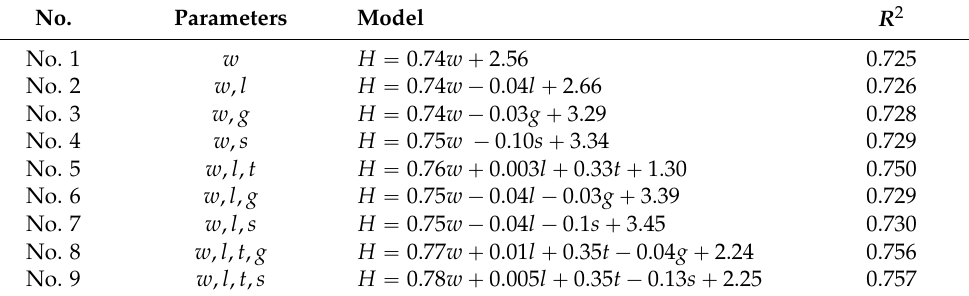
Table 1. Model fitting forest height lists.